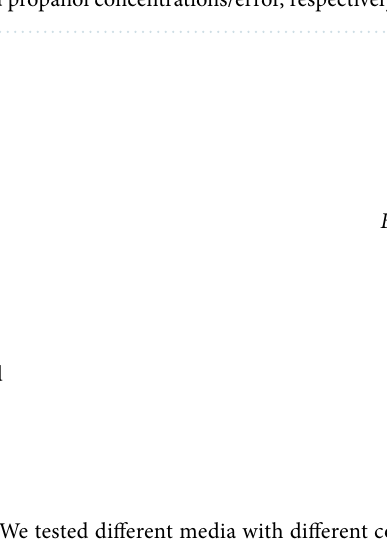
Table 3. Actual (input) and detected (using our method) concentration composition for different multi- element media as well as the percentage error. c W /e W , c M /e M , c E /e E and c P/ /e P are the water, methanol, ethanol and propanol concentrations/error,